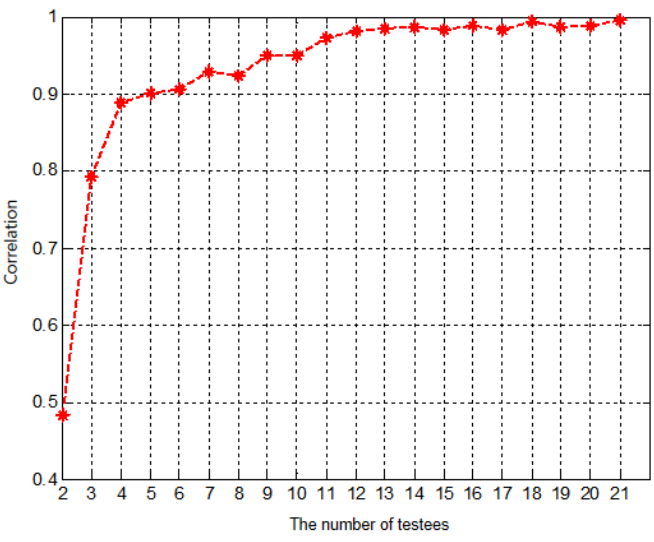
Figure 9. The data saturation validation in our test.